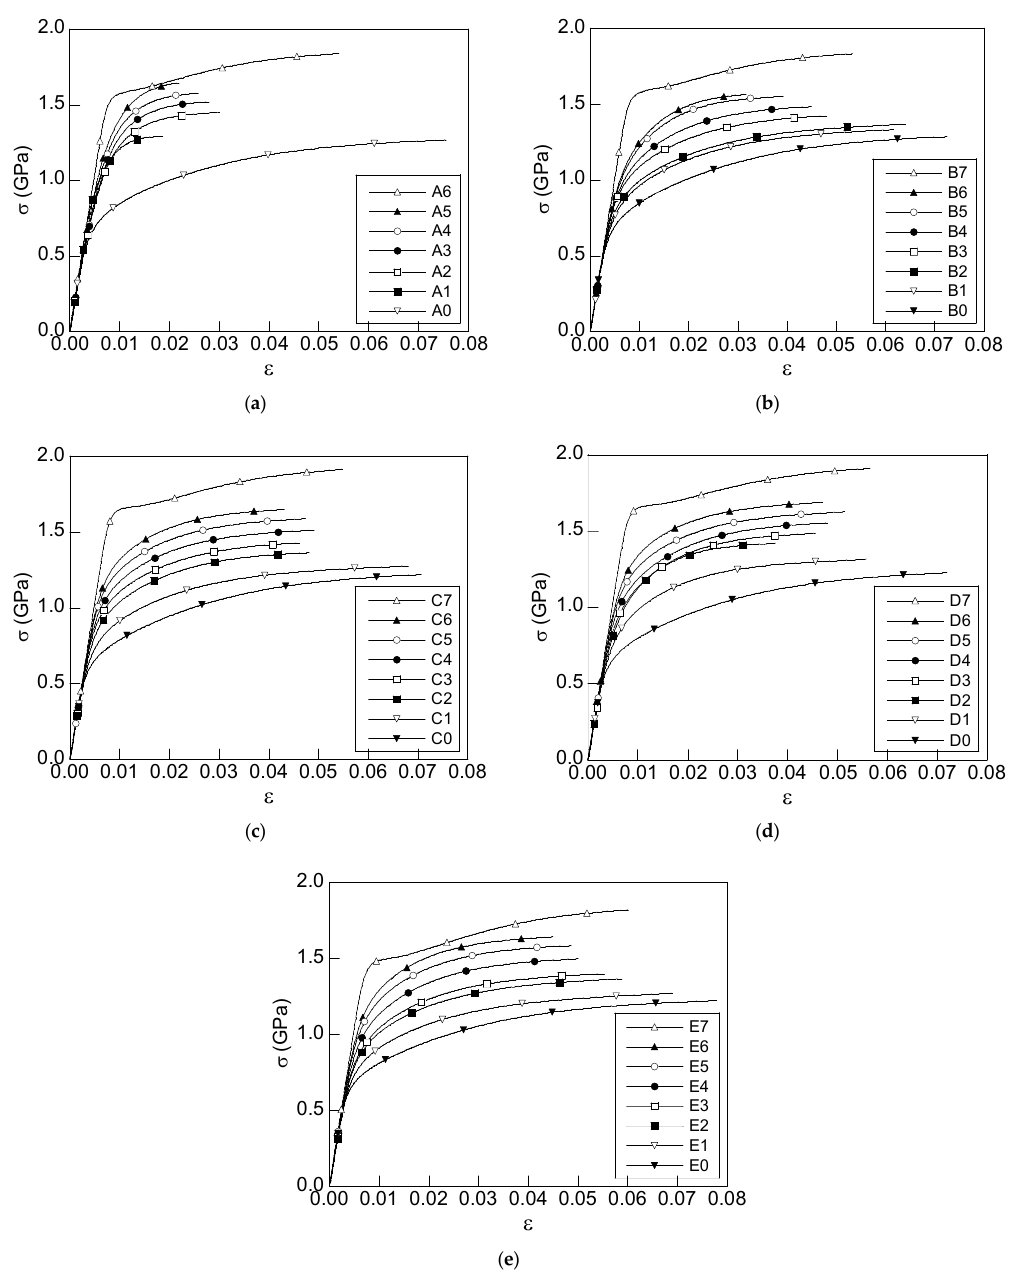
Figure 6. Stress-strain curves of the progressively-drawn steels: ( a ) family A with six drawing degrees; ( b ) family B with seven drawing degrees; ( c ) family C with seven drawing degrees; ( d ) family D with seven drawing degrees; and ( e ) family E with seven drawing